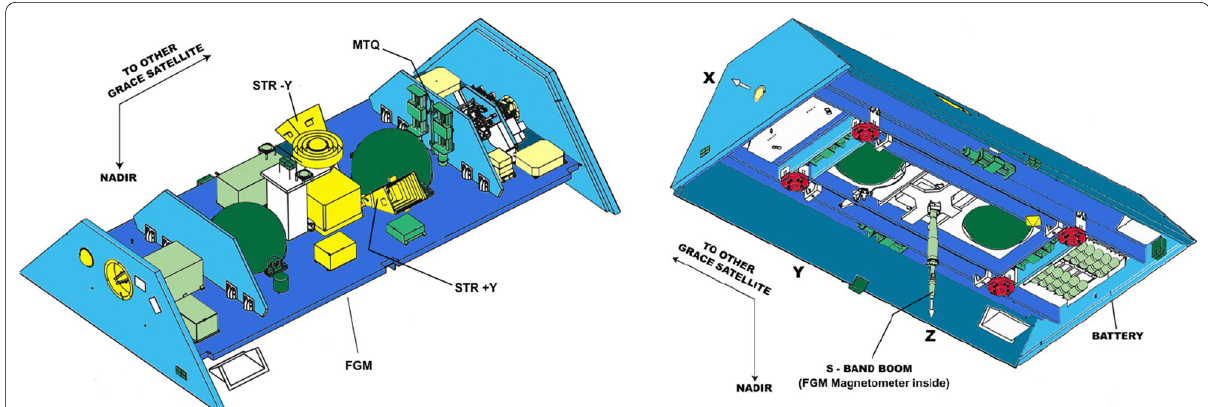
Fig. 2 The location of the fluxgate magnetometer (FGM), magnetorquers (MTQs), and star trackers (STRs) on each of the GRACE